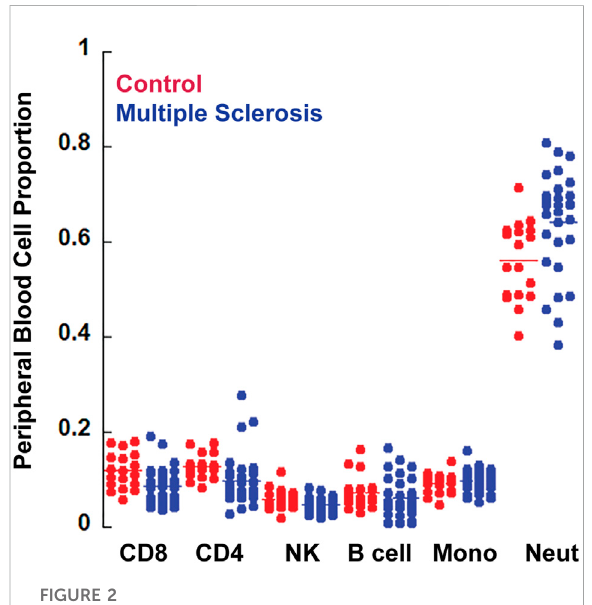
FIGURE 2 Cell composition analysis. The CellCounts2 function in the FlowSorted.Blood.EPIC package in R software was used to estimate differential peripheral blood cell counts. No statistically signi fi cant differences were observed between MS and